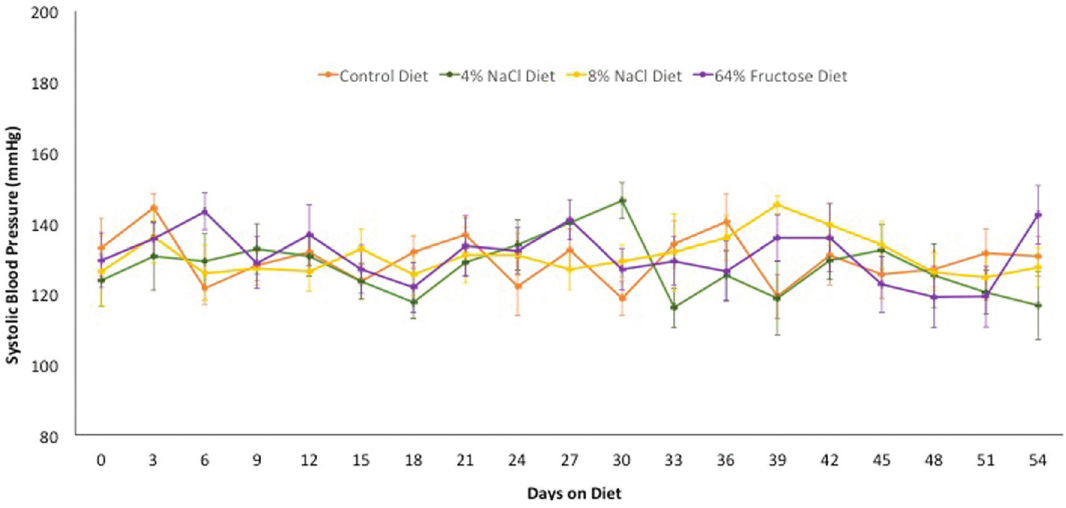
Figure 5 - Systolic blood pressure remained constant in Sprague-Dawley rats placed on a 4% NaCl, 8% NaCl, or 64% fructose diet for 8 weeks. Systolic blood pressure was measured using the standard tail cuff method, and averages with a standard deviation greater than 30 were discarded. (n = 12-14 rats per diet